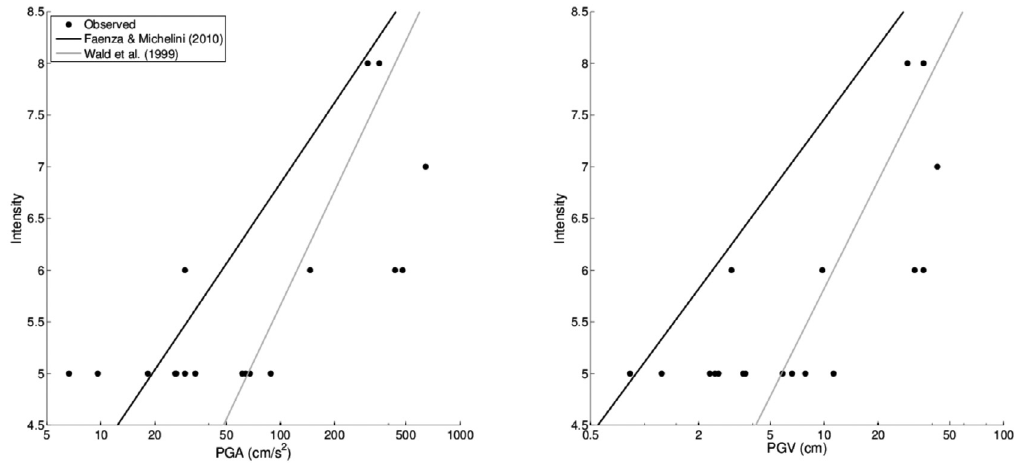
Figure 5. Comparison of intensities observed in the L’Aquila earthquake and those predicted by the GMICEs of Faenza and Michelini [2010] and Wald et al.